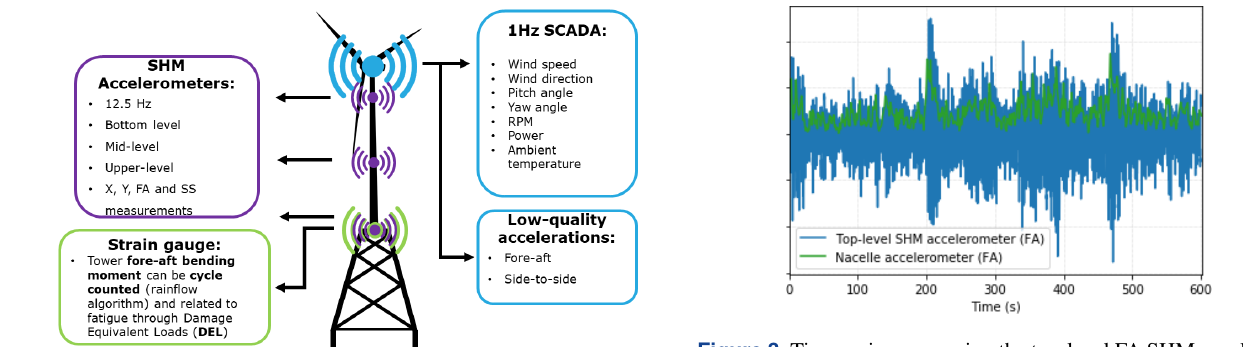
Figure 3. Time series comparing the top-level FA SHM accelerom- eter signal and the nacelle-installed FA